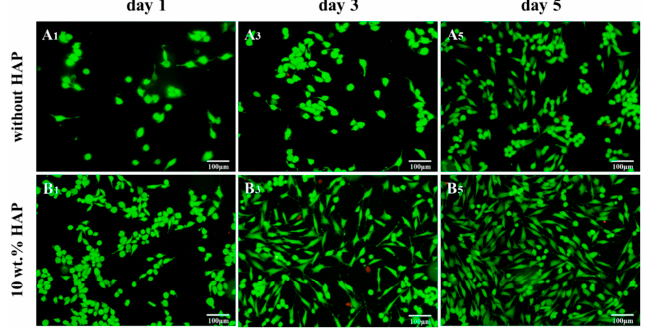
Figure 34. Fluorescence images of MG63 cells cultured on PEEK-20 wt% PGA (top panel) and PEEK-20 wt%PGA/10 wt% nHA (bottom panel) scaffolds for different time periods. HAP: